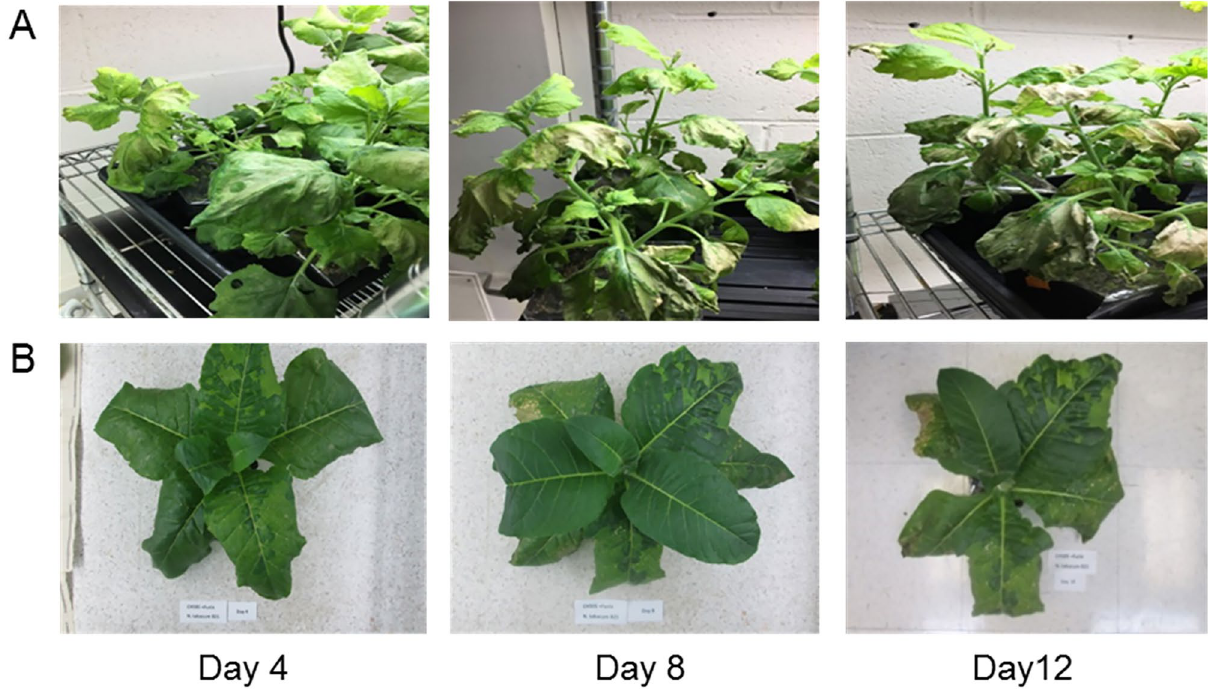
Figure 2. Phenotypic screening for SOSIP transgene overexpression induced stress in Nicotiana plants following infiltration with CH505 SOSIP genes. ( A ) N. benthamiana and ( B ) N. tabacum plants. Note: Holes in leaves represent areas where a leaf sample was taken. Upper leaves were removed from the N. tabacum plant to get a better view on the lower infiltrated leaves at days 4, 8 and 12.